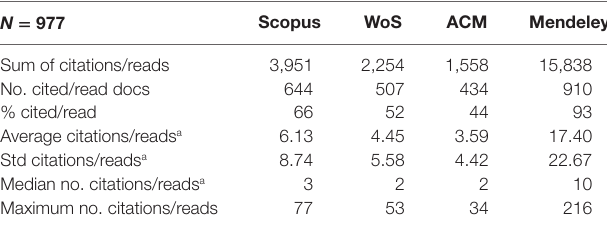
taBlE 6 | General characteristics of the documents retrieved by all three databases.